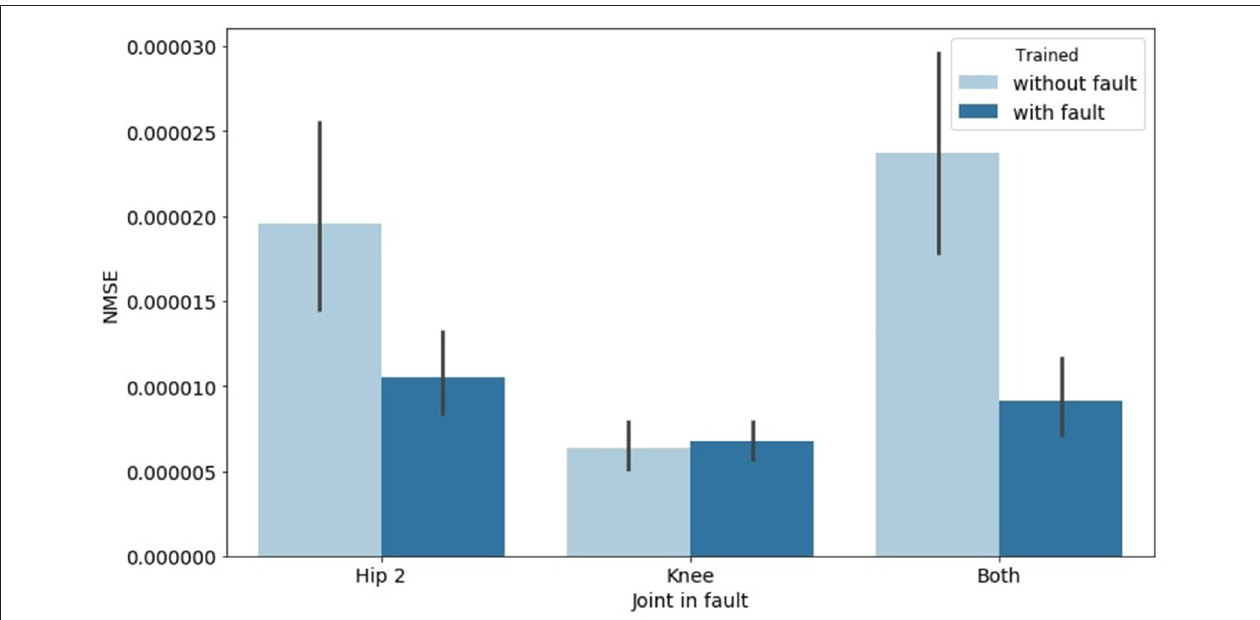
FIGURE 7 | Behavior of GRF prediction NMSE when the fault occurred on Hip 2, Knee, or both front right leg joints. The error was computed as the average of all four legs. The brighter bar shows the measured error when the model was trained without artificial faults, whereas the darker one was obtained from a model trained with artificial